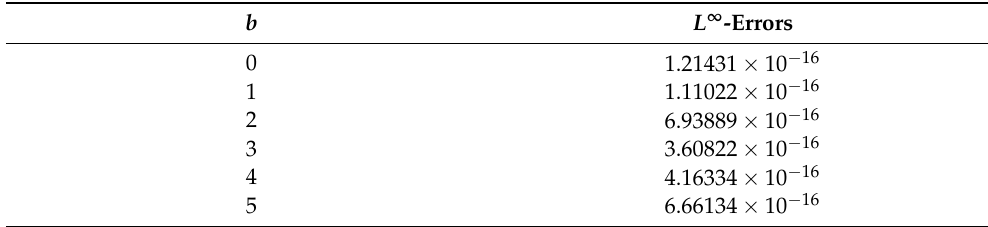
Table 3. L ∞ -errors of our algorithm at υ 1 = 0.5 and N = 2 with distinct b for Example 2.